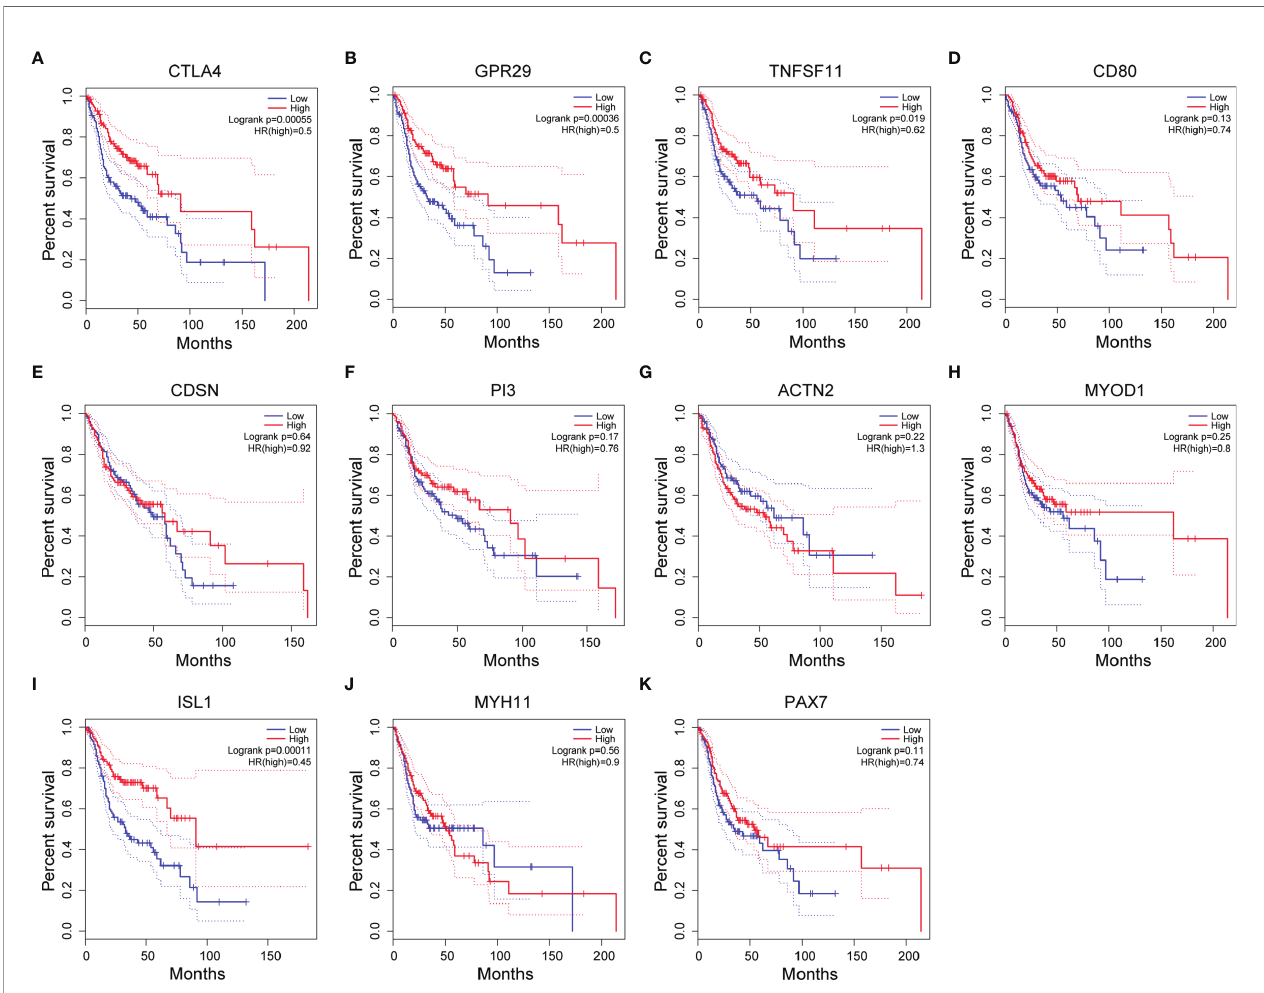
FIGURE 6 | Associations between the expression level of hub genes and overall survival (OS) of HNSC patients. (A – K) Kaplan-Meier plots showing the OS of HNSC patients of 11 potential hub genes. Blue line: OS curve for patients with hub gene expression lower than the 25 th percentile. Red line: OS curve for patients with hub gene expression higher than the 75 th